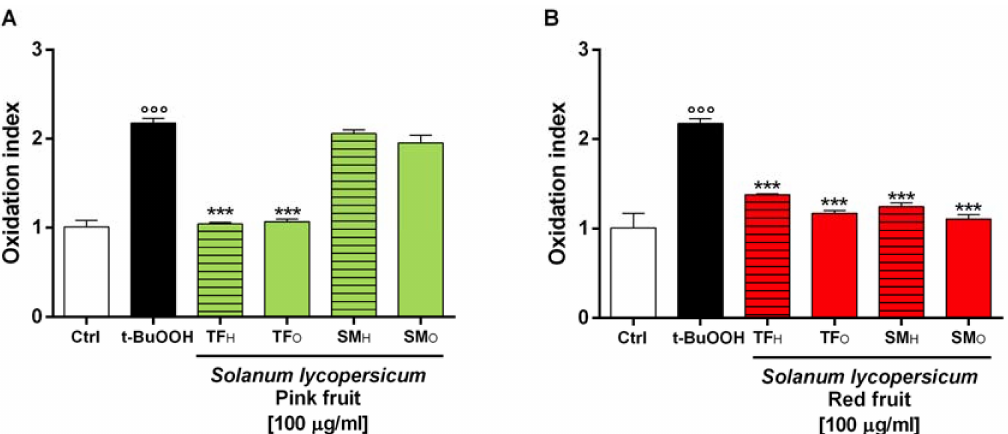
Figure 7. E ff ect of the organic and hydroalcoholic extracts from the fruits of Solanum lycopersicum var. Torpedino di Fondi (TF) and San Marzano (SM) at ( A ) pink and ( B ) red ripening stages on the t BuOOH-induced intracellular ROS levels by the DCFH-DA (2,7-dichlorofluorescein diacetate) assay. t BuOOH (5 mM) TF H , TF O , SM H , SM O . The oxidation index was obtained by the ration between the DCF fluorescence of the sample and that of the vehicle control (i.e., EtOH 1% v / v ). *** p < 0.001, represent a statistically significant di ff erence of the treatment with respect to t BuOOH (Anova + Dunnett’s multiple comparison post test). ◦◦◦ p < 0.001, represent a statistically significant di ff erence of t BuOOH vs. Ctrl. p < 0.001, represent a statistically significant di ff erence of t BuOOH vs.